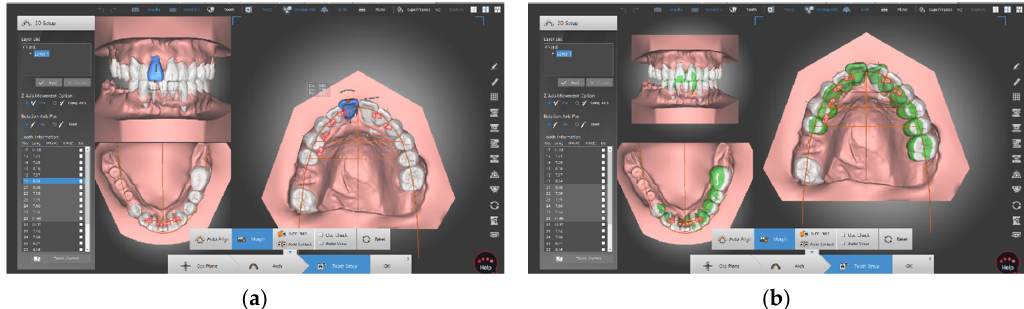
Figure 8. ( a ) Photograph showing that each tooth can rotate and move parallel to the bucco-palatal (bucco-lingual) and mesio-distal. ( b ) A photograph of overlapping existing occlusion (green) and final occlusion (white).